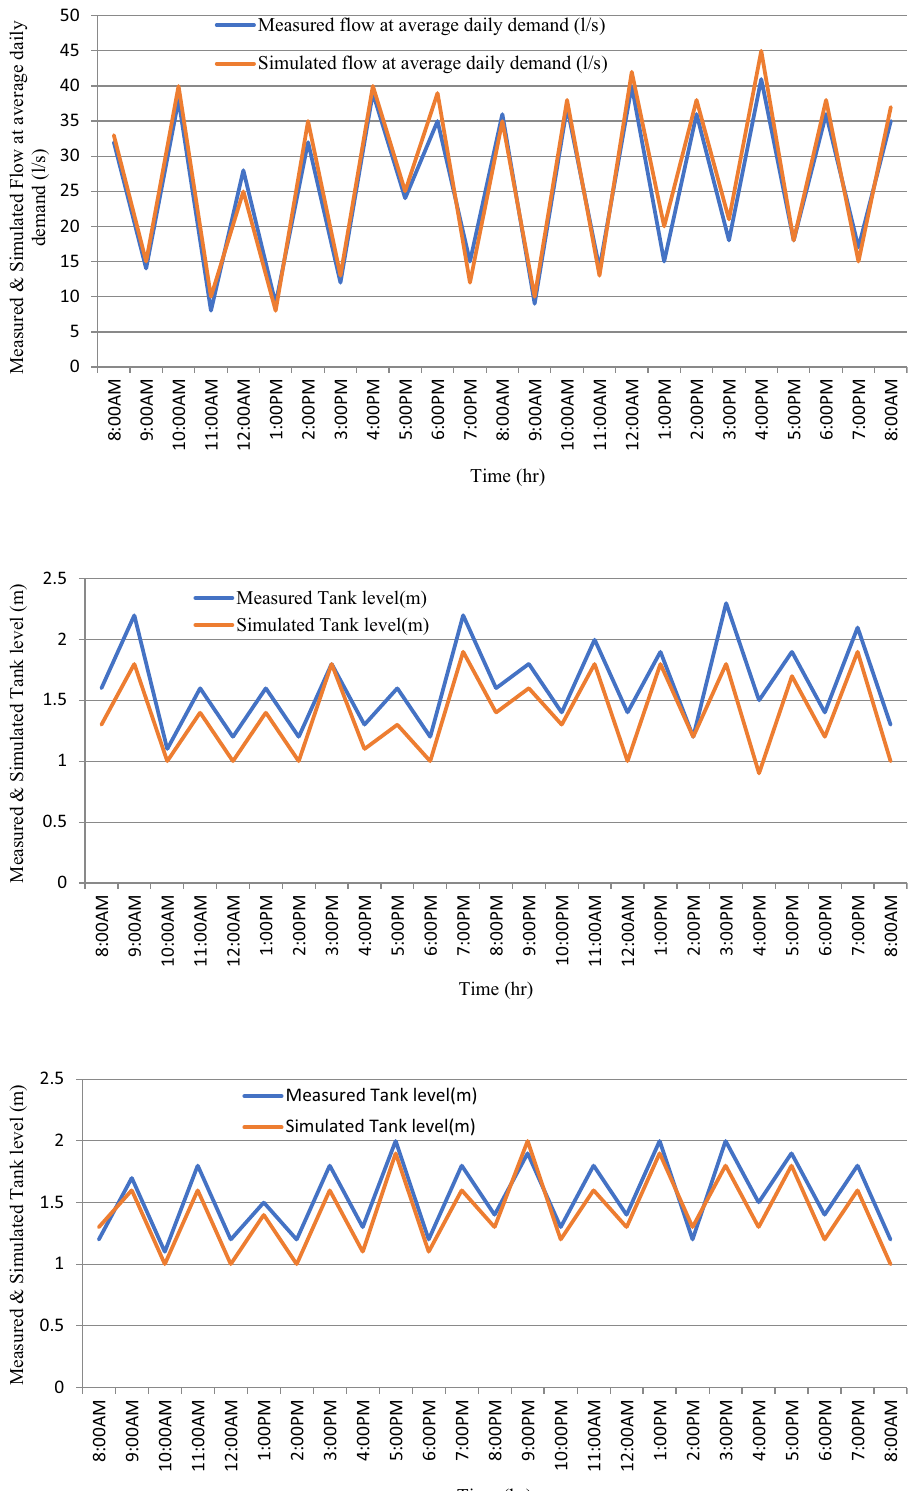
Fig. 7 Validation of pipe flow during average daily demand at pipe No.86